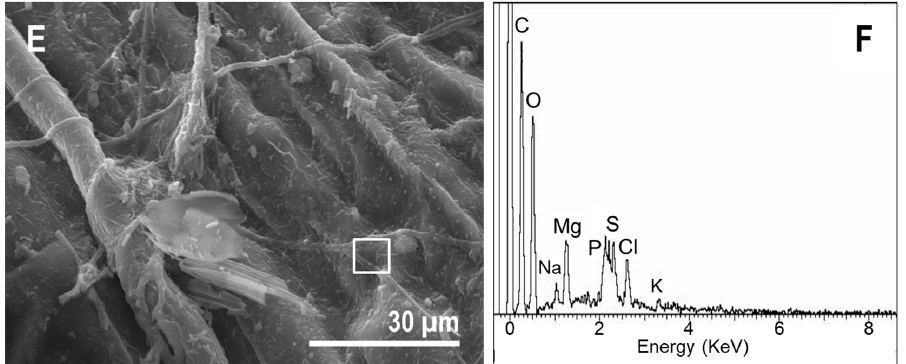
Figure 10. SEM-EDXS images of the microbial sarcophagus growing over ferns at day 30 ( A , C ) and at day 60 ( E ). ( B , D , F ) correspond to the EDXS spectra of the sites highlighted in ( A , C , E ) respectively.